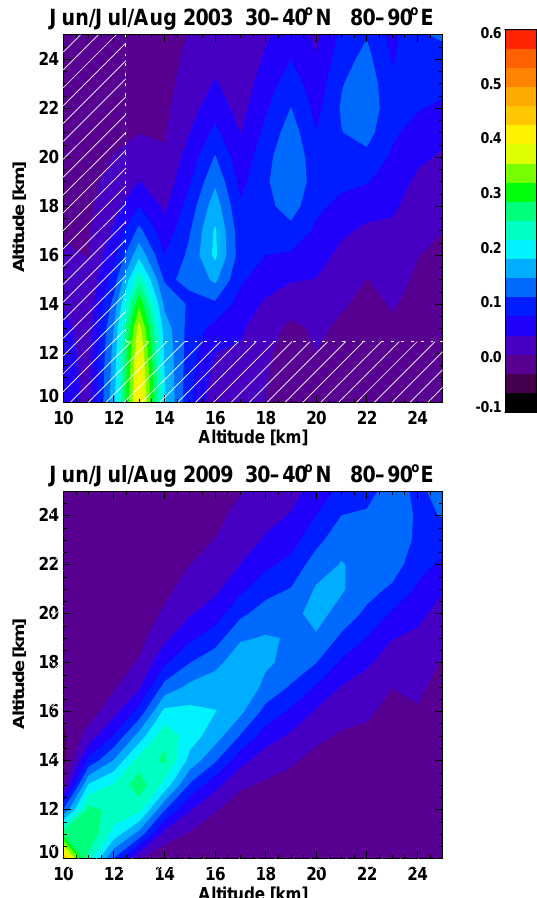
Figure 3. Averaging kernels of the MIPAS NH 3 retrieval during the first (top) and second (bottom) MIPAS measurement period. The number of degrees of freedom up to 25km is 2.1 (top) and 3.5 (bottom). Hatched areas indicate altitudes below the lowest tangent height where no measurement information is